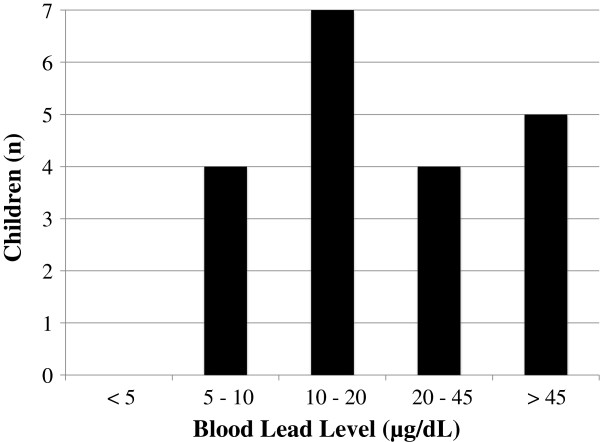
All children had detectable blood lead levels (BLLs). Among the 20 children in the study all had BLLs greater than 5 μg/dL, the CDC’s reference blood level for children. This included five children with BLLs greater than 45 μg/dL, the level at which chelation therapy is recommended.